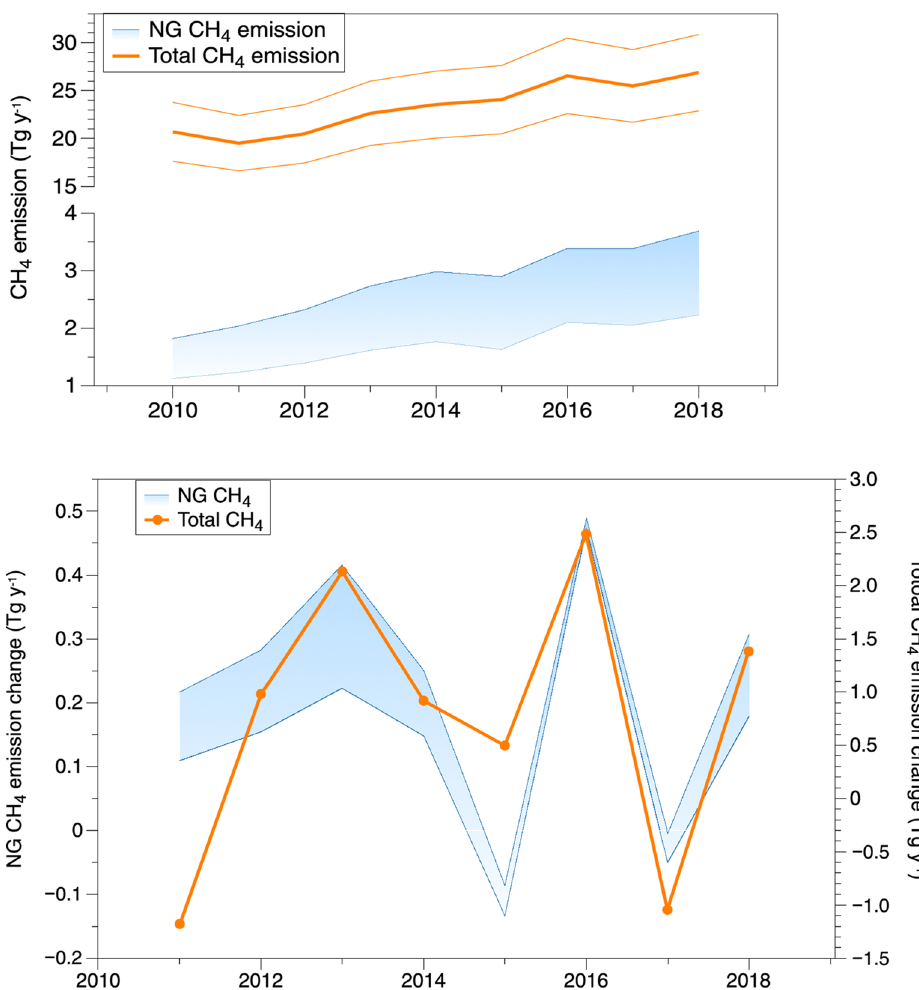
Figure 4. Estimated CH 4 emissions from NG (up and low range) and total CH 4 emission (estimation in a solid line with uncertainty in shadow in NE during 2010–2018 (left panel) (detailed data in Supplementary Table S2) and CH 4 emission increment relative to previous year (right